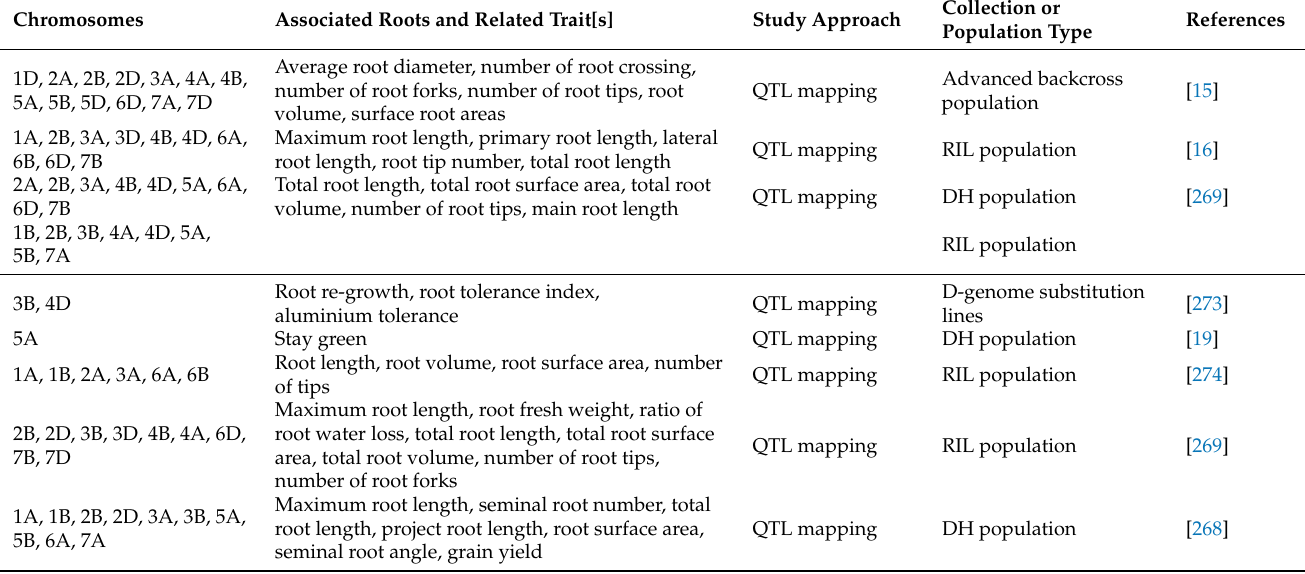
Table 6. Putative QTL regions for drought-related traits in wheat mapping populations under either individual or drought, heat and non-stressed